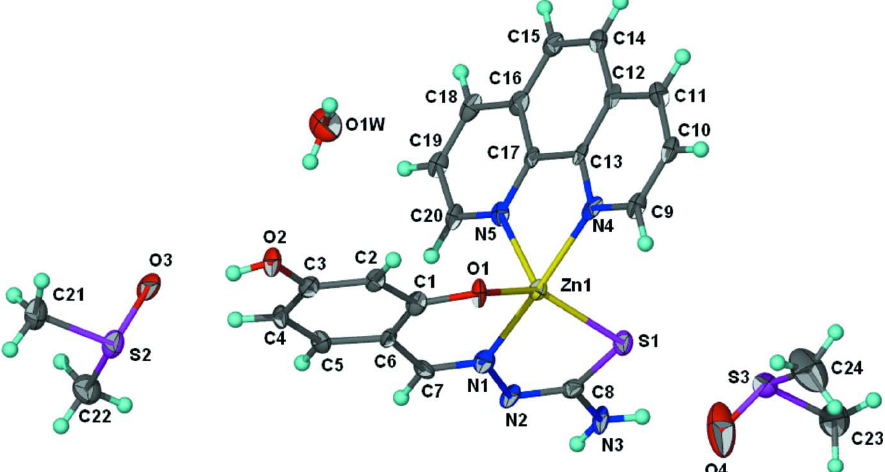
Figure 1 Thermal ellipsoid (Barbour, 2001) plot of Zn(C atoms are drawn as spheres of arbitrary radii. The disorder in the DMSO is not